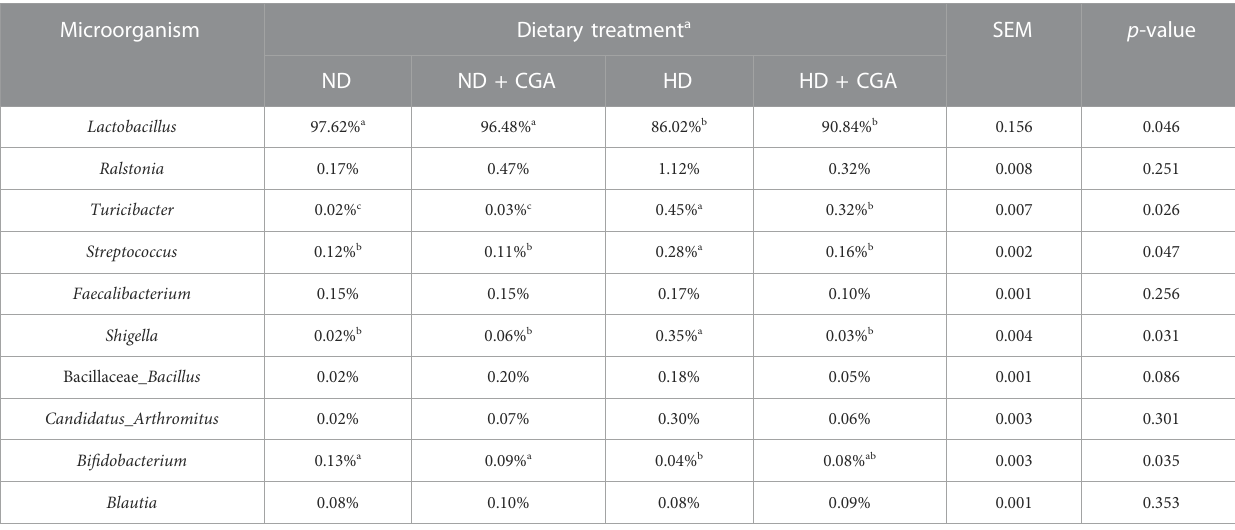
TABLE 5 Composition of ileum microbiota of broilers at genus